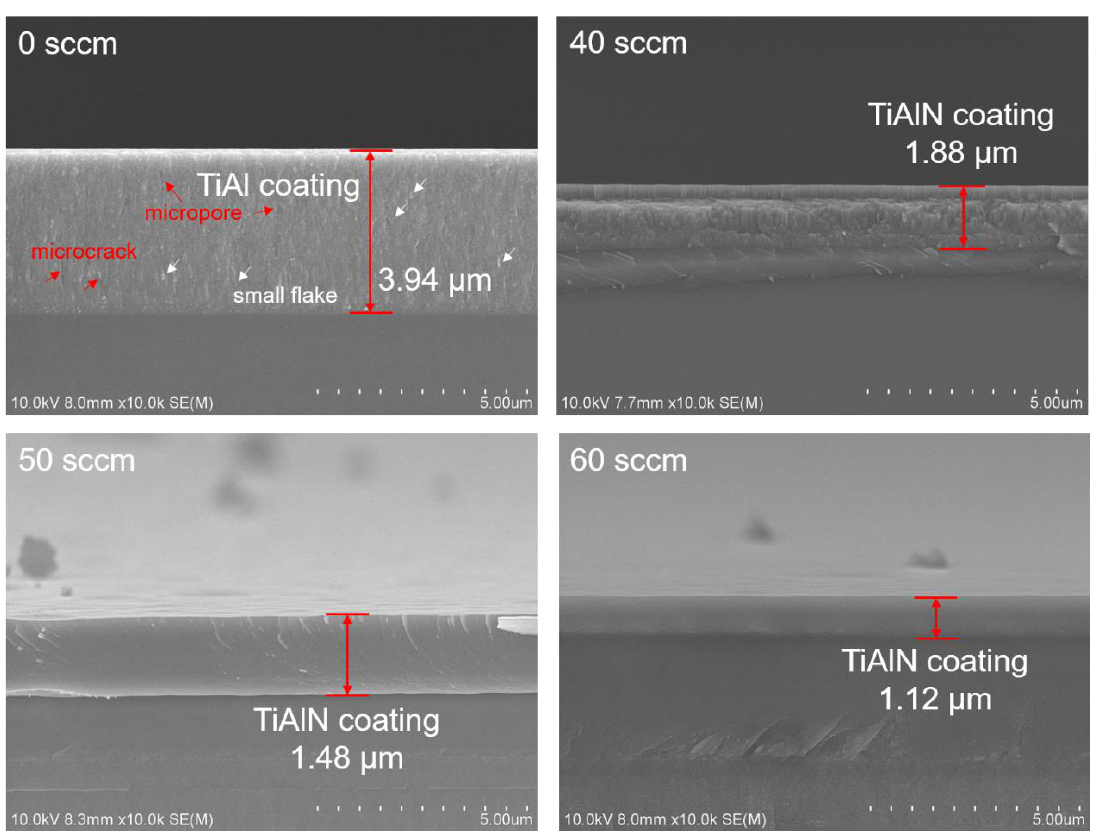
Figure 6. The cross-sectional images of the samples prepared under different nitrogen flux rates.